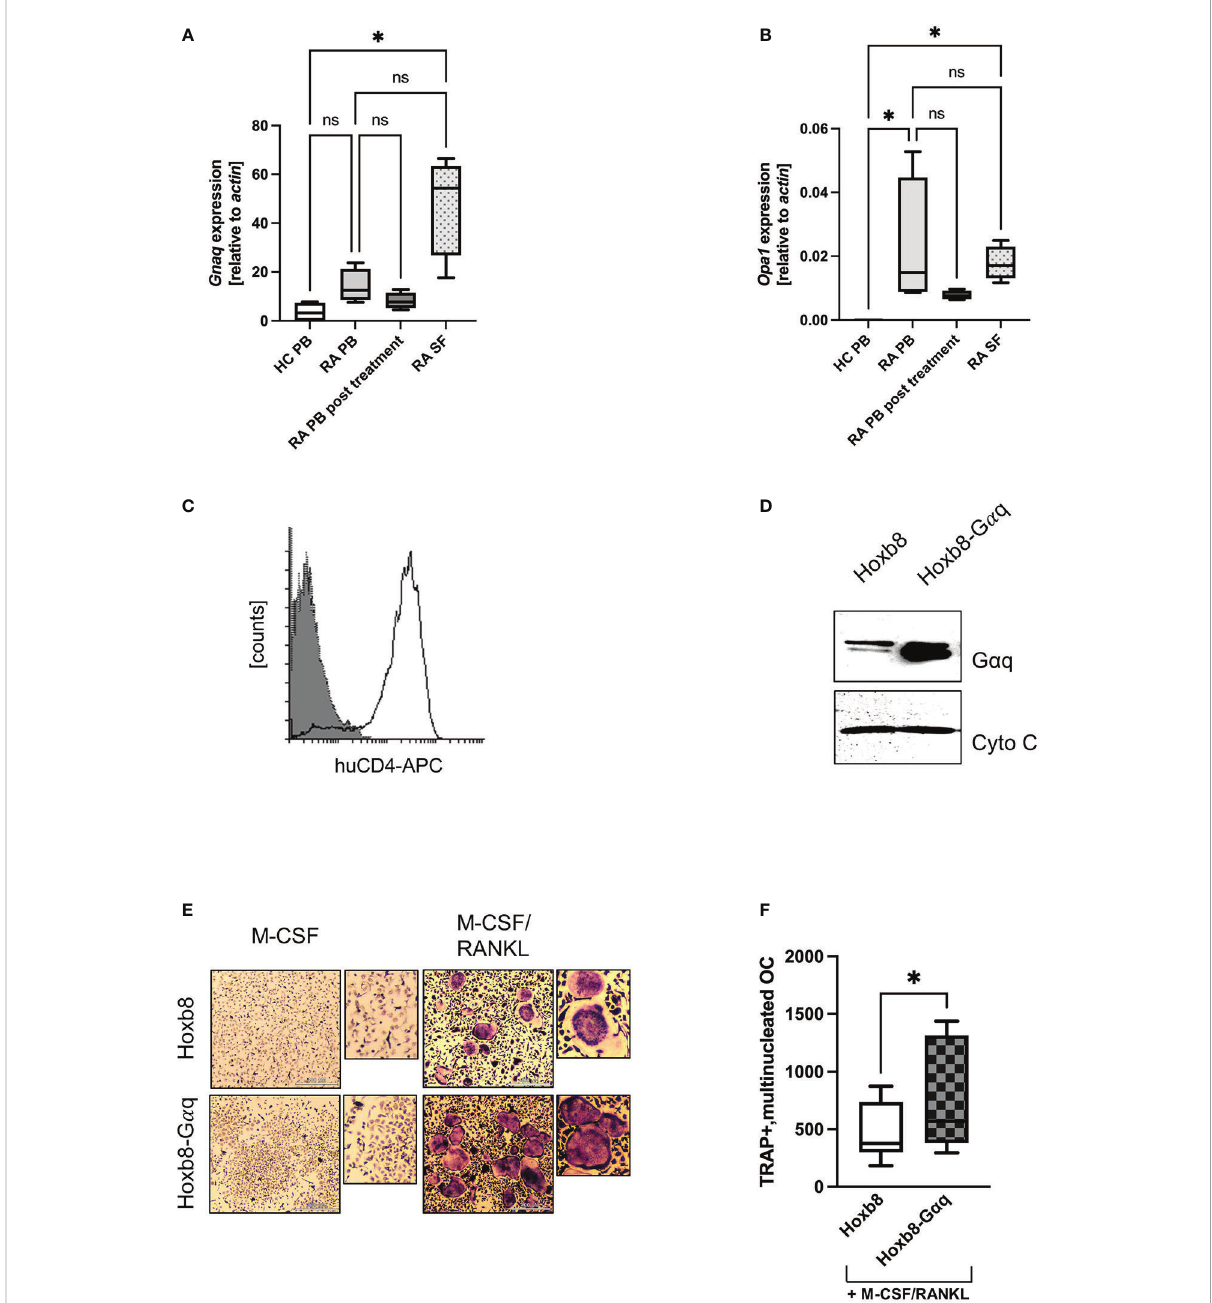
FIGURE 5 Overexpression of G a q in ER-Hoxb8 cells causes a hypermetabolic phenotype. (A) GNAQ and (B) OPA1 expression was quanti fi ed by RT-PCR using peripheral blood (PB) from healthy controls and RA patients, as well as synovial fl uid from RA patients. In addition, PB of post-treatment RA patients was analysed (n=4). Statistical analysis was done using a Friedman test. (C) ER-Hoxb8 cells were retrovirally transduced with murine G a q and successful transduction was veri fi ed by FACS analysis for huCD4. (D) Overexpression of G a q and Cytochrome C as loading control. (E) TRAP assays were performed to study the effect of G a q on OC formation of ER-Hoxb8 cells. Cells were stained for TRAP and multinucleated, TRAP positive cells were quanti fi ed in (F) (n=4). Statistical signi fi cance was evaluated with a 2-way ANOVA